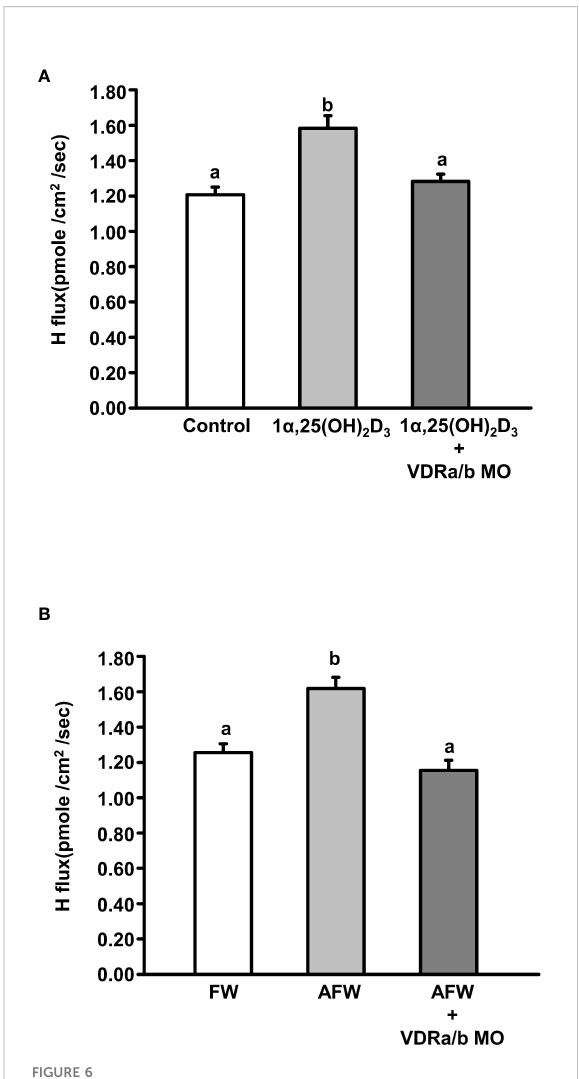
FIGURE 6 The effect of VDR MOs on proton secretion of acid-secreting ionocytes in 3 dpf zebra fi sh larvae treated with (A) 1 a ,25(OH) 2 D 3 and (B) AFW. SIET was used to measure H + fl ux on the skin. Different letters indicate a signi fi cant difference (p < 0.05), as determined using one-way ANOVA followed by Tukey ’ s multiple-comparison test. Values were expressed as the mean ± SEM (n =